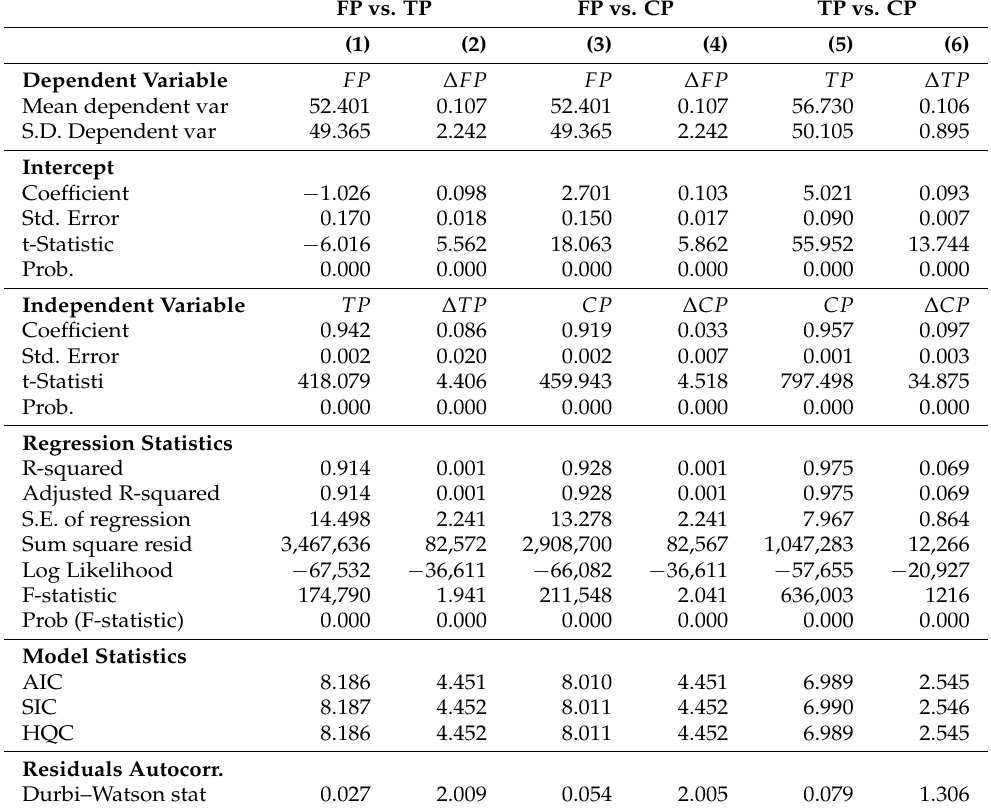
Table A4. Post-crisis period panel